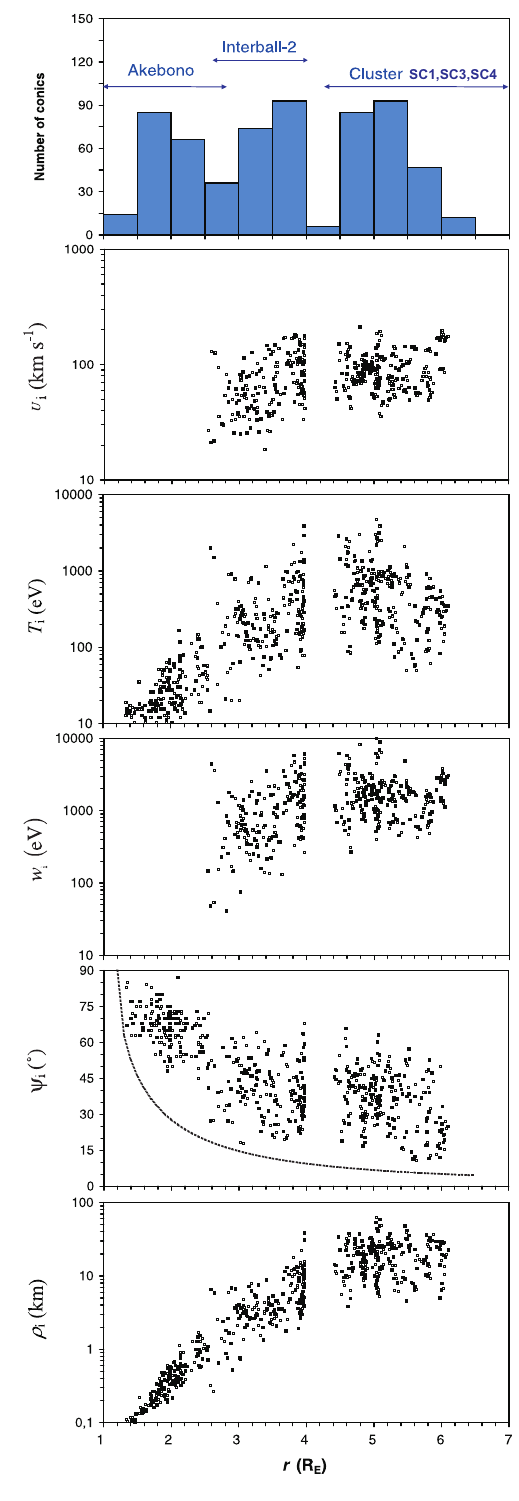
Fig. 4. From top to bottom, number of ion conical distributions per altitude range, and scatterplots of different oxygen ion quantities: upward mean velocity in kms − 1 , temperature in eV, mean energy in eV, apex angle in ◦ , and mean gyroradius in